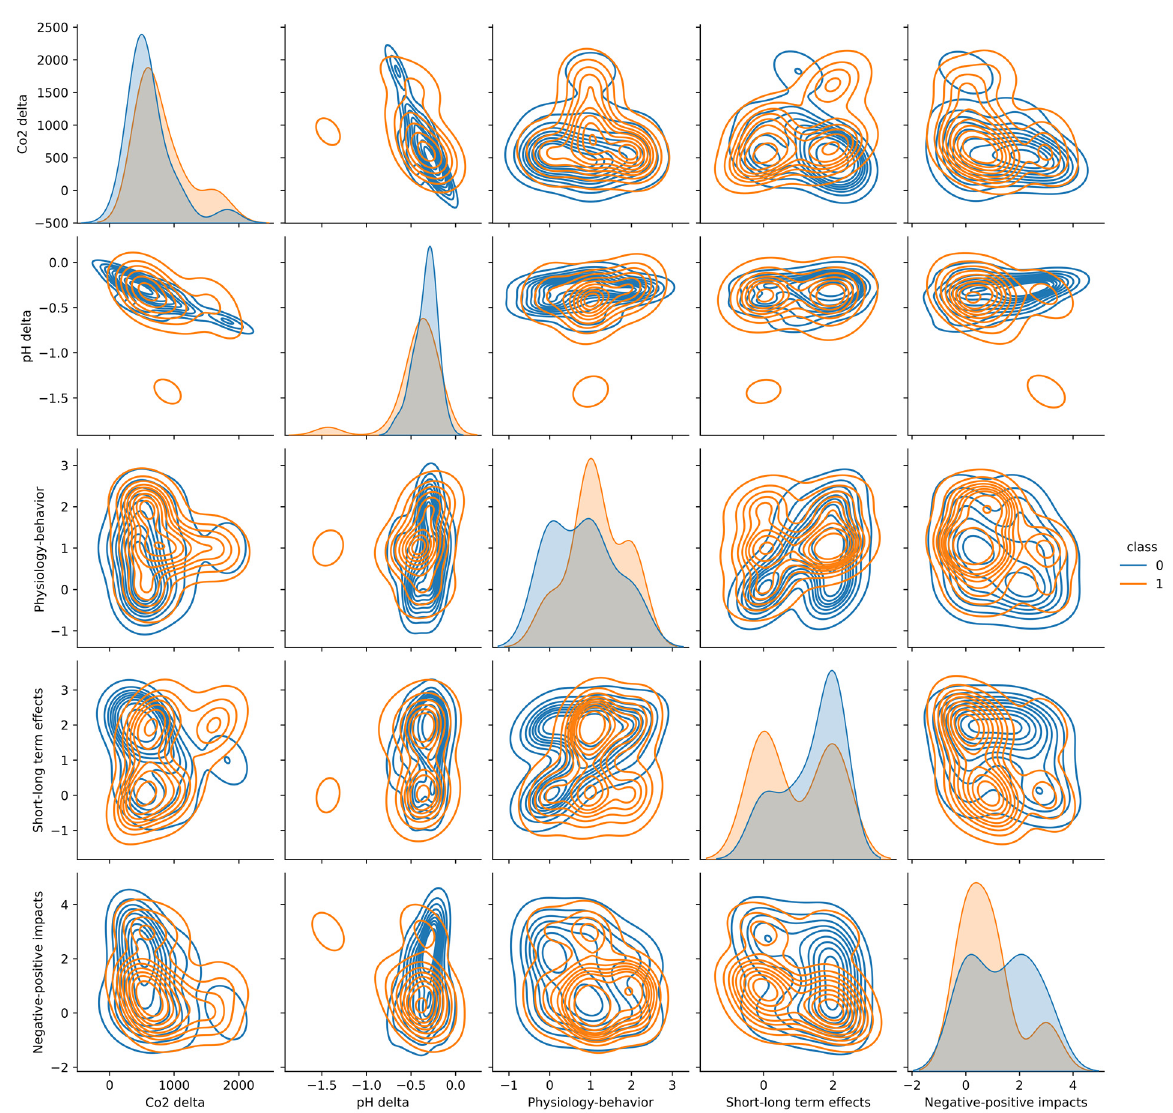
Figure 3. Comparison of the distribution of each factor in F , using the kernel density estimate (KDE) method. Orange for elasmobranch and blue for bony fish.